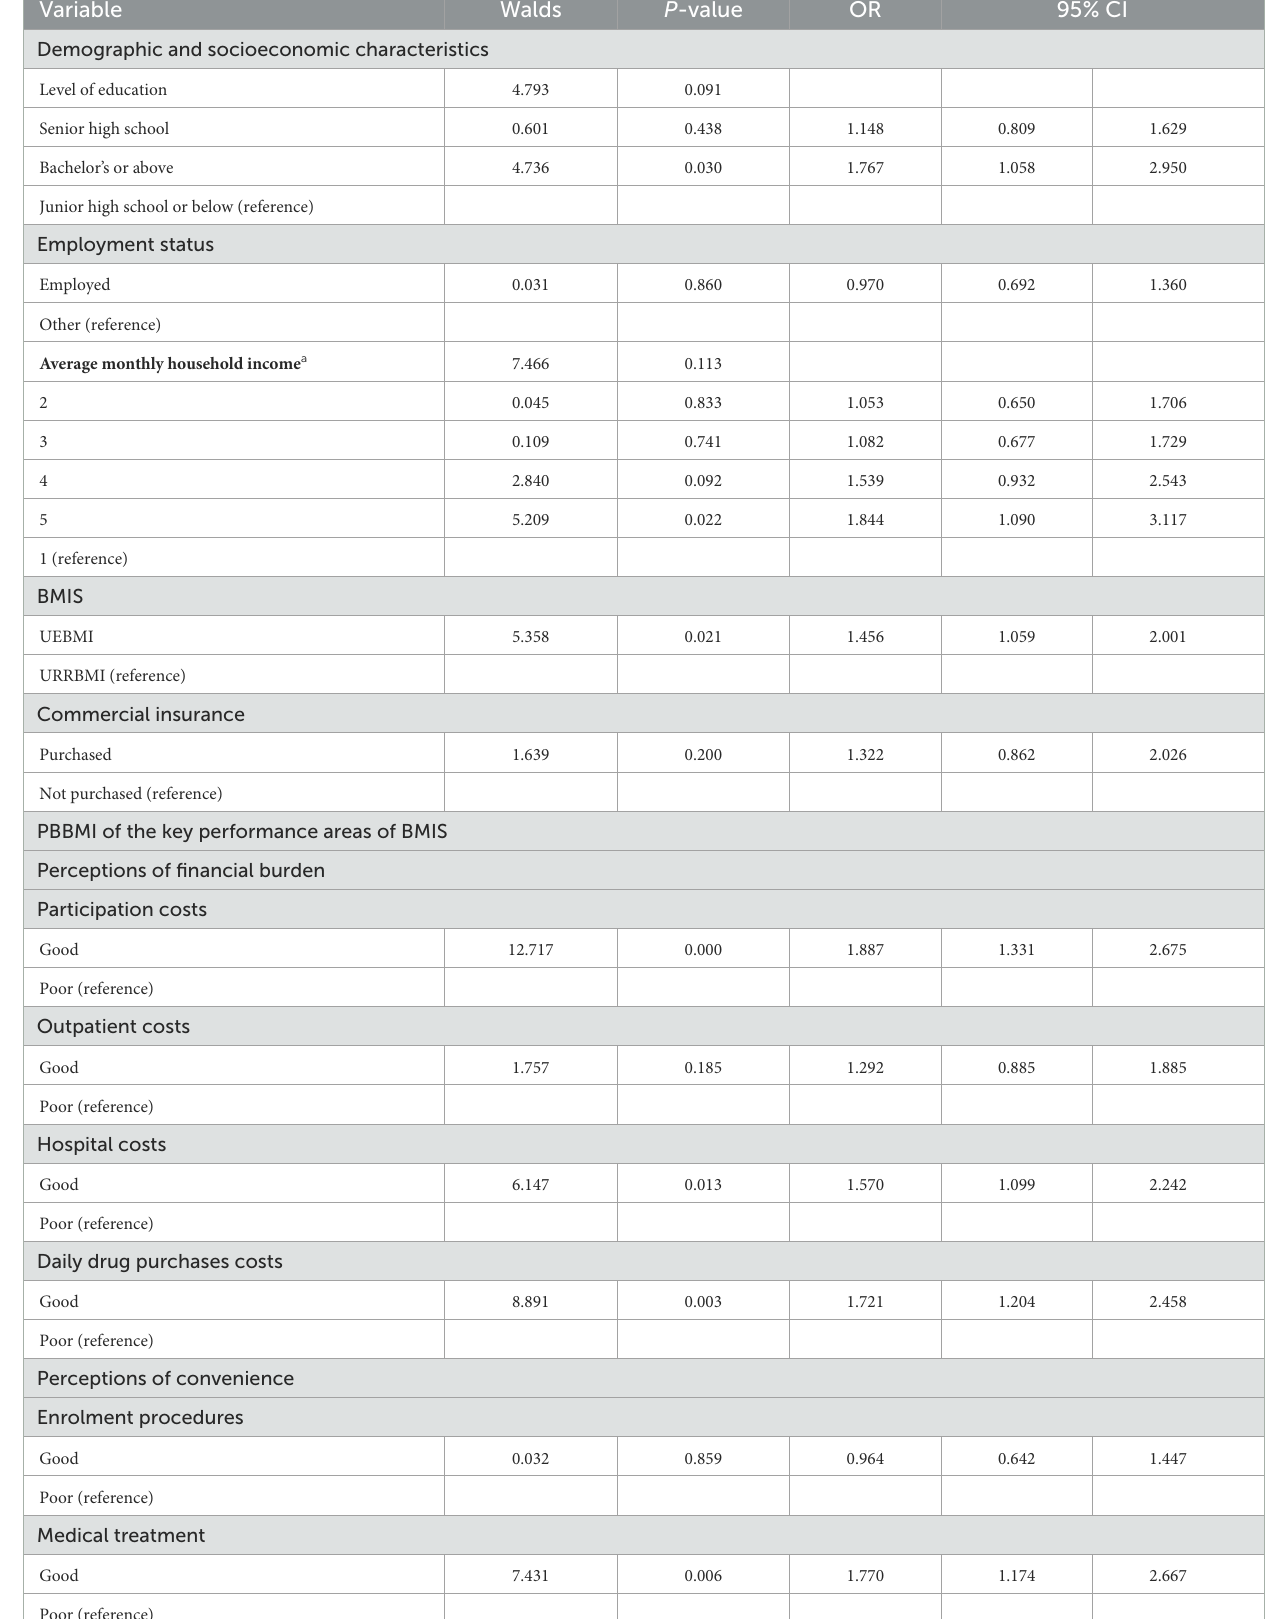
TABLE 2 Logistic regression analysis on the PBBMI.